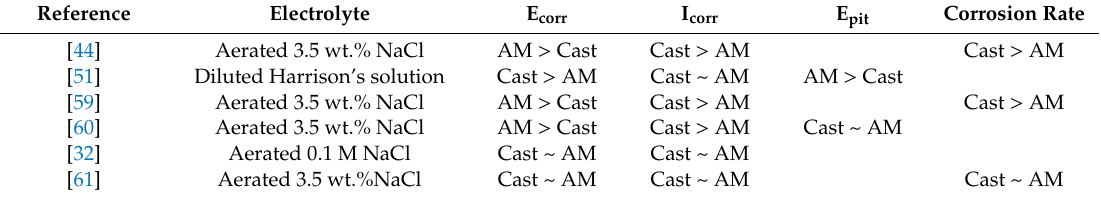
Table 1. Comparison between Cast and as-built AM AlSi10Mg from results obtained in potentiodynamic polarization tests. Only results acquired in polished / ground samples were considered. E corr , I corr , and E pit refer to corrosion potential, corrosion current density, and pitting potential,